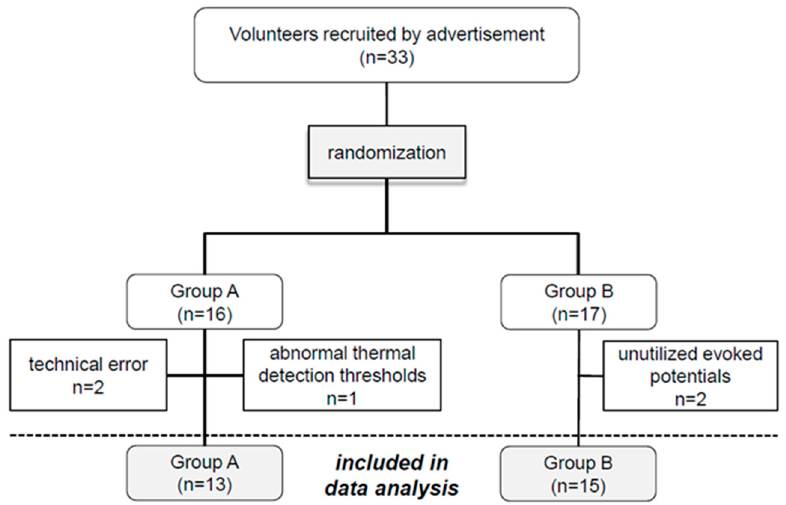
Figure 2. Randomization and exclusion of study participants.